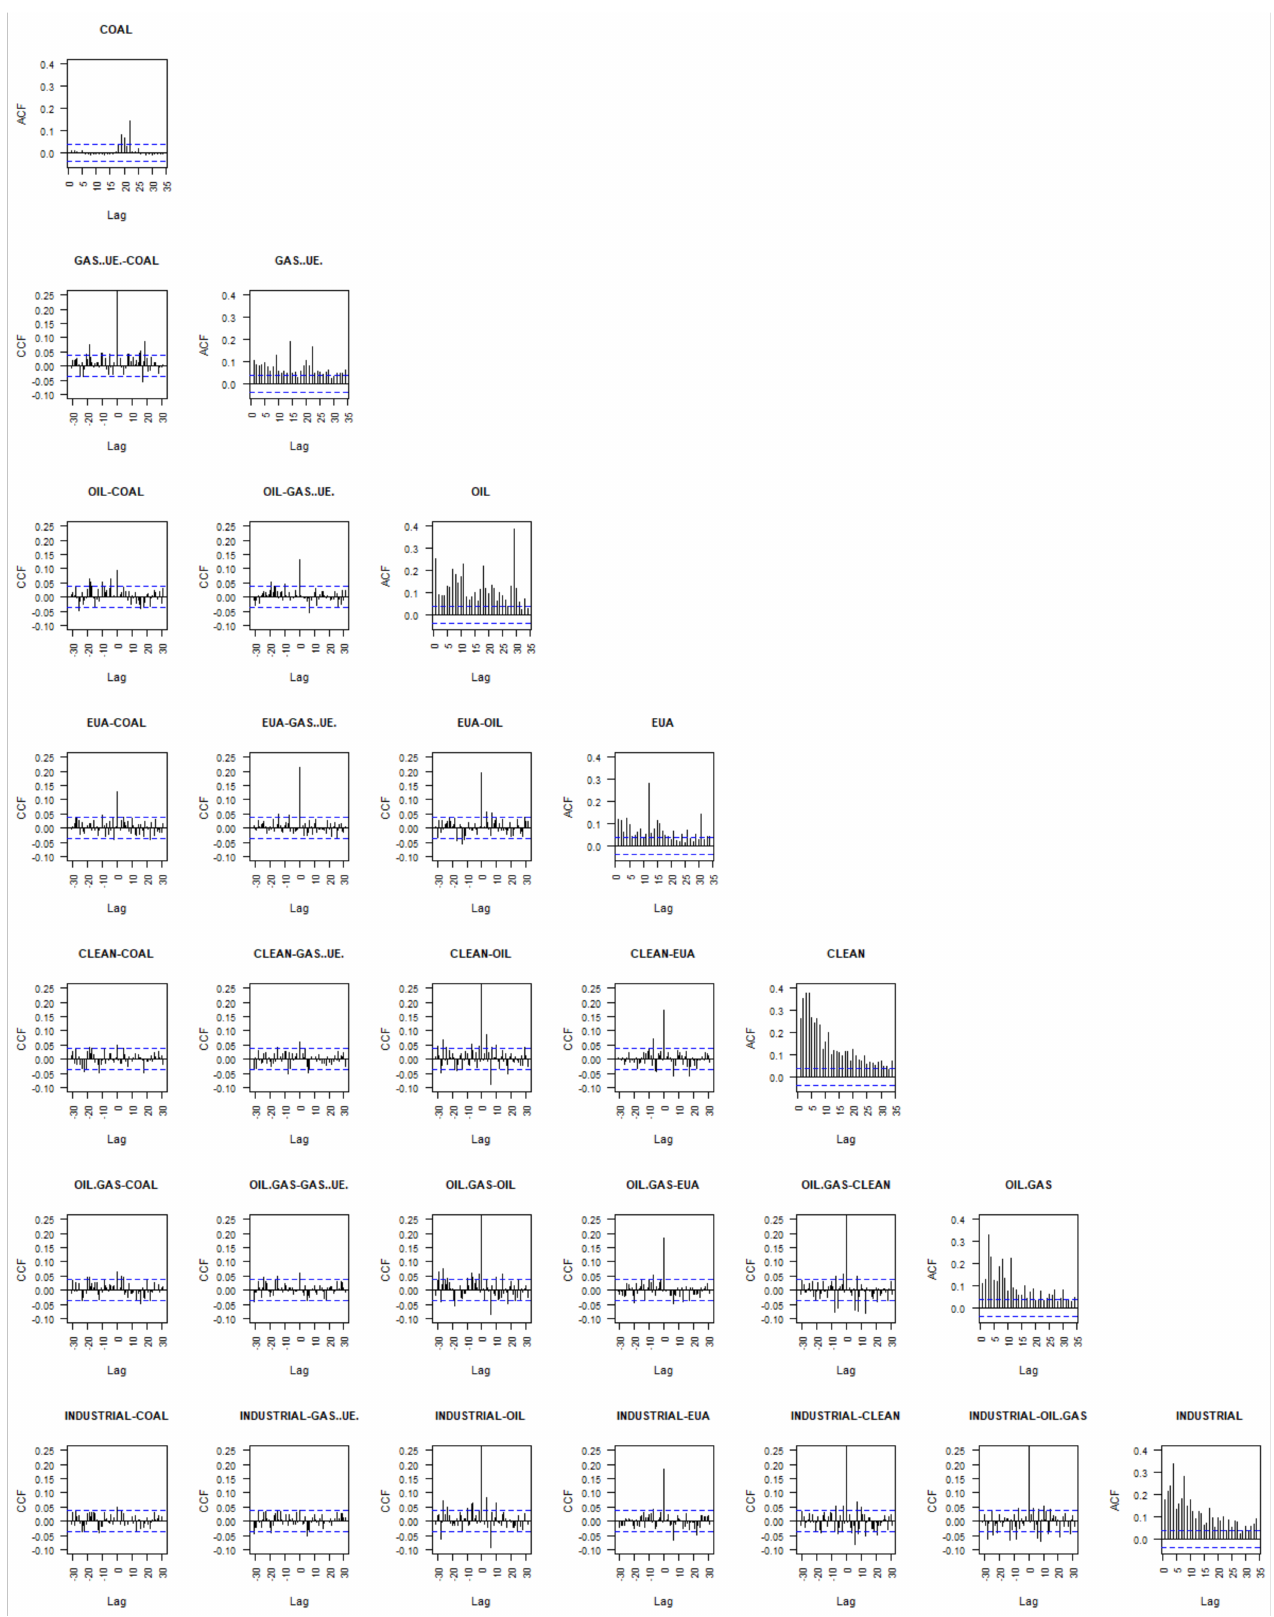
Figure 4. Matrix graph with the cross-correlation function of the residuals of the VAR(1) model in the off-diagonal cells, and with the autocorrelation function of the quadratic residuals in the